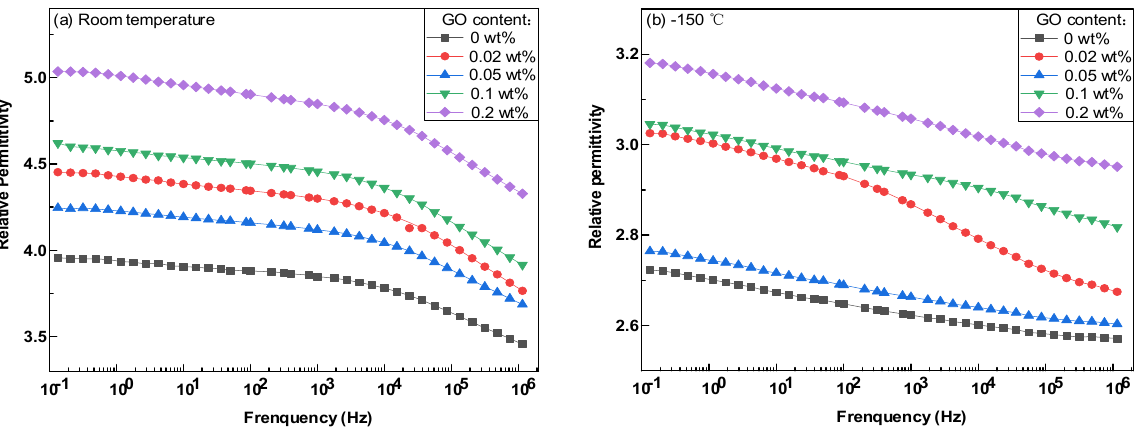
Figure 4. Spectrum of relative permittivity of epoxy nanocomposites at room temperature and − 150 °C. ( a ) Spectrum of relative permittivity of epoxy nanocomposites at room temperature; ( b ) Spec- trum of relative permittivity of epoxy nanocomposites at − 150 °C .